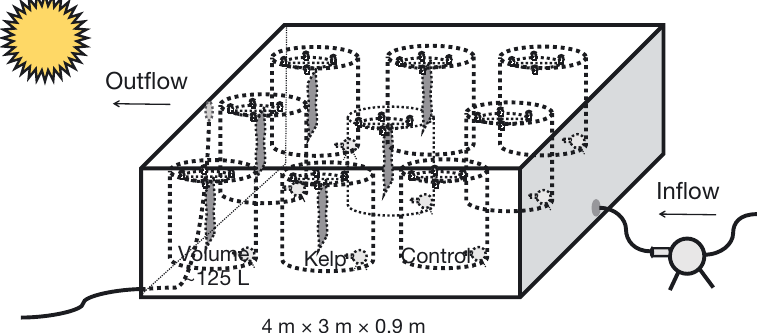
Fig. 2. Schematic diagram of the incubation experiment system. The cylinder containers (40 cm in diameter and 100 cm in height) were placed in a large storage tank into which seawater was continually pumped to maintain a water temperature similar to that of natural seawater. Submersible pumps were placed on the side wall of cylinder to simulate the hydrodynamic conditions in the